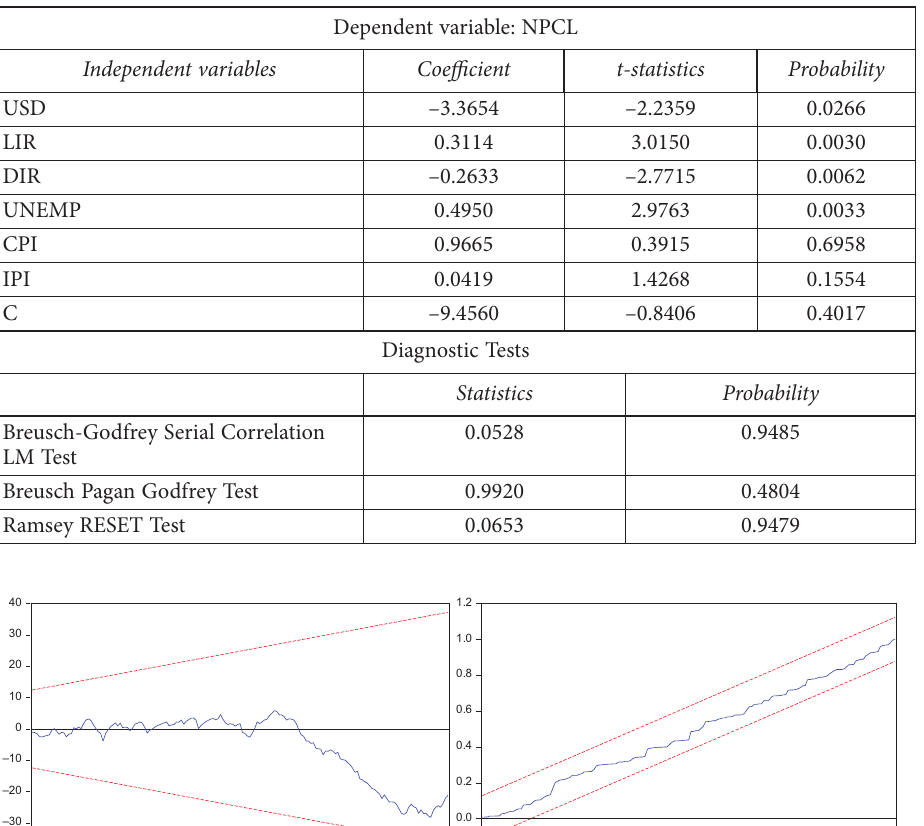
Table 5. Long-run coefficients estimation results (source: own calculation of author)